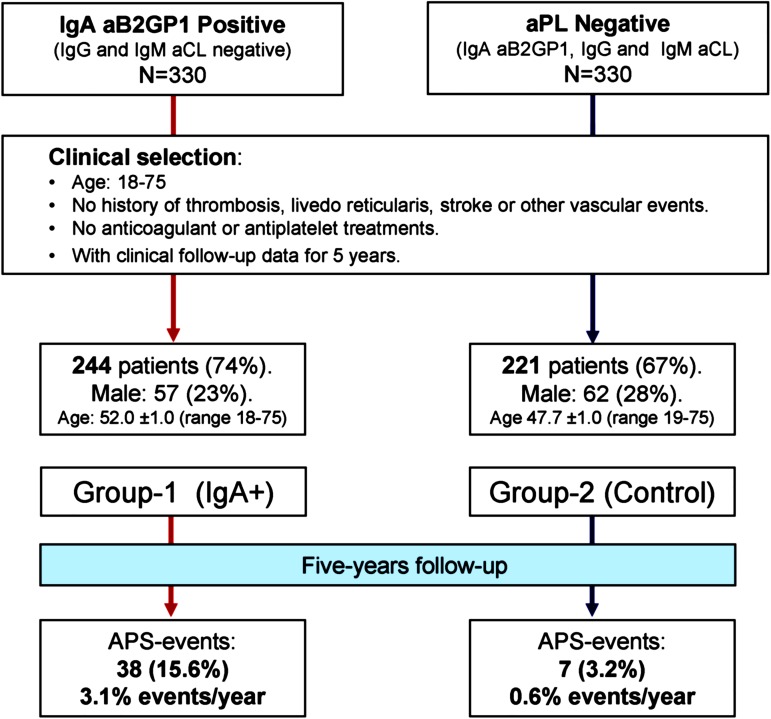
Study disposition and main outcomes.